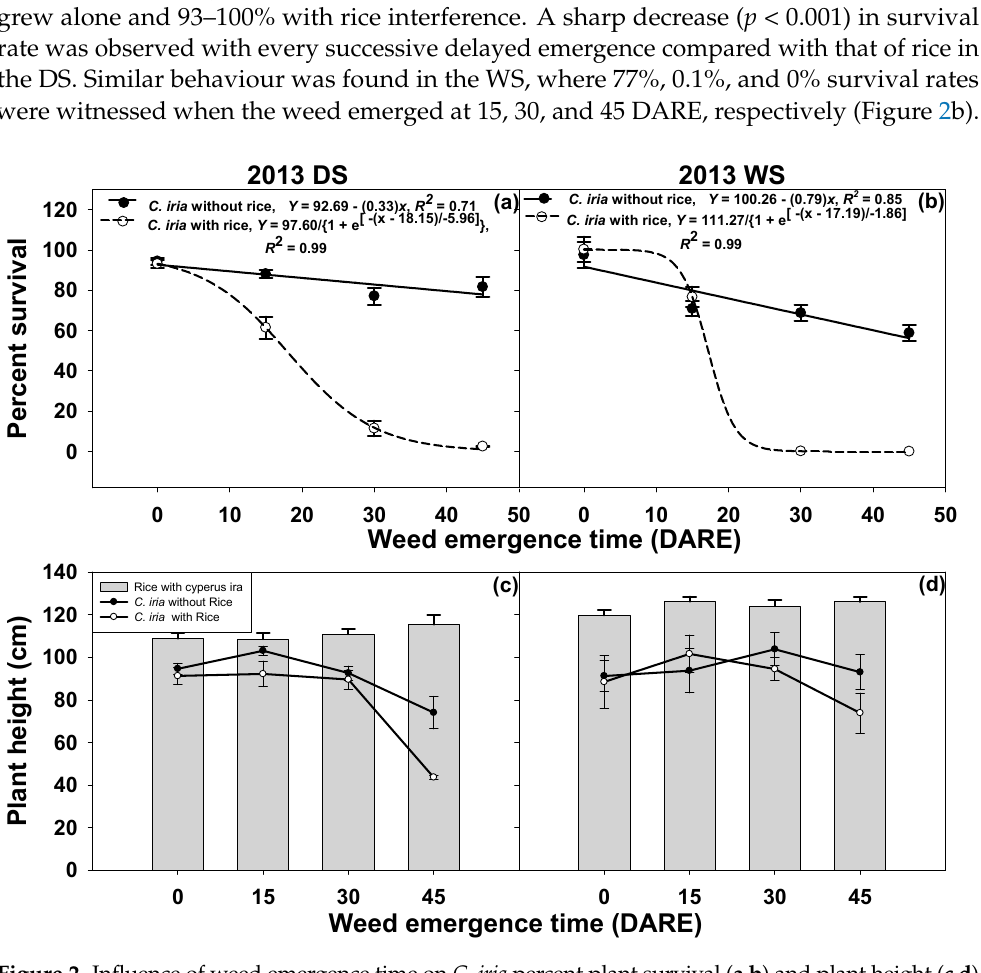
Figure 2. Influence of weed emergence time on C. iria percent plant survival ( a , b ) and plant height ( c , d ) of C. iria and rice. Models fitted to the data for C. iria grown without rice interference (Rice 0) are shown by solid lines, and those fitted to the data for C. iria grown with rice at the rate of a 50 kg ha –1 seed rate (Rice 50) are shown by broken lines. The height of rice plants is shown by a bar graph. Equations are used to show the estimated parameters. The standard error of the means is repre- sented by vertical bars. 3.1. Plant Height C. iria emerging at 3 DARE attained plant heights of 91–95 cm when growing alone and 88–91 cm when allowed to grow with rice competition (Figure 2c,d). Decreased weed plant height in both seasons was observed with rice interference, and the variation amongst emergence cohorts surged with delaying emergence. Delay in weed emergence in comparison with rice emergence had little effect on plant height at 3, 15, and 30 DARE, but after this, it decreased significantly in the DS. However, this resulted in variable re- sponses in C. iria height in the WS; after a slight increase, a decreasing trend in plant height was observed (Figure 2c,d). 3.2. Tiller Density per Plant The tiller density plant − 1 of C. iria decreased linearly in the DS and exponentially in the WS (Figure 3). Weeds growing without rice competition in the DS had 25 tillers plant − 1 , while 20 tillers plant − 1 were recorded in plots suffering from rice competition. The corre- sponding values in the WS were 14 and 9. Rice competition reduced ( p < 0.001) tiller den- sity by 58–66% when the weed had an emergence time of 15 DARE and by 70–100% when it had an emergence time of 30 DARE (Figure 3a,b). Regression analysis indicated that